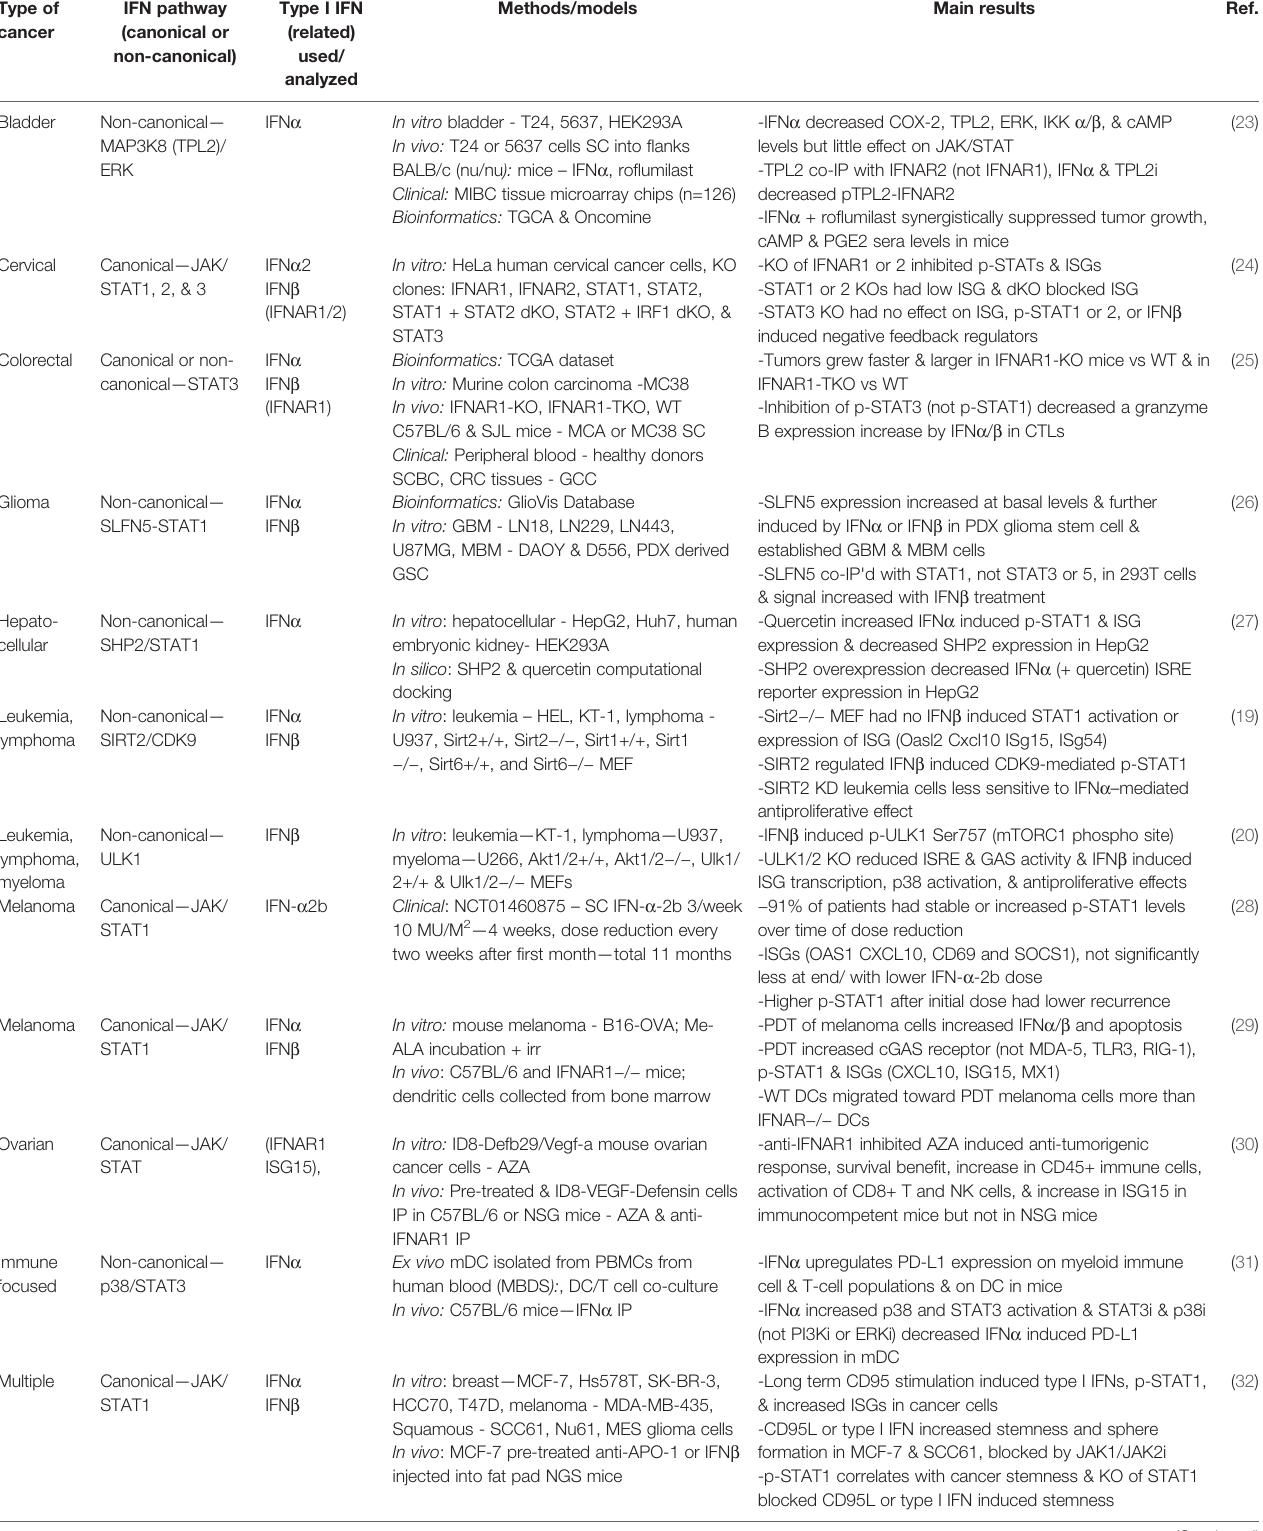
TABLE 1 | Canonical and non-canonical type I interferon signaling in malignancies. Type of